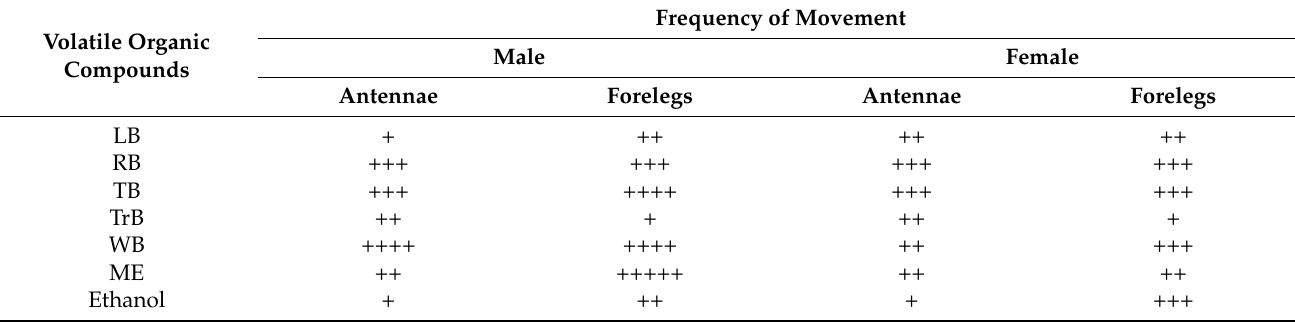
Table 4. The olfactory chemosensory responses of Oriental fruit flies to volatile organic compounds and different basil essential